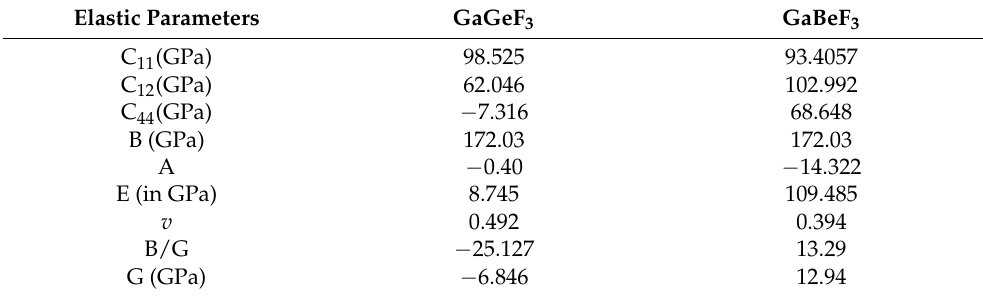
Table 2. For ternary GaMF 3 (M = Ge and Be) compounds, the calculated elastic constants, bulk modulus, anisotropy factor, Young’s modulus, Poisson’s ratio, Pugh ratio (B/G), and Cauchy’s pressure are shown. Elastic Parameters GaGeF 3 GaBeF 3 C 11